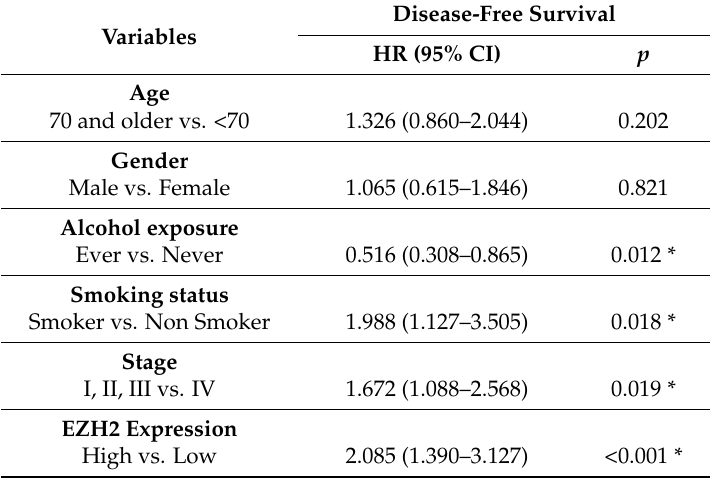
Table 2. Multivariate analysis of factors affecting survival using Cox proportional hazards model in 230 HNSCC